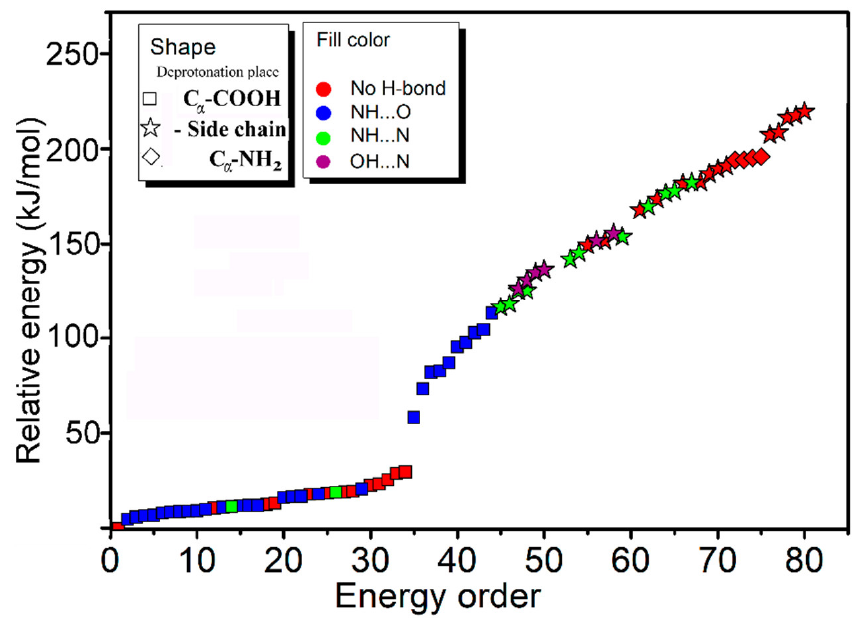
Figure 2. A statistical view on the 80 isomers of [Arg+Rb+K − H] + corresponding to their energy orders based on the method of B3LYP/6-311++G(d,p)~LAN and their structural characteristics. Table 1. Relative energies and structural parameters of some isomers obtained with different methods.